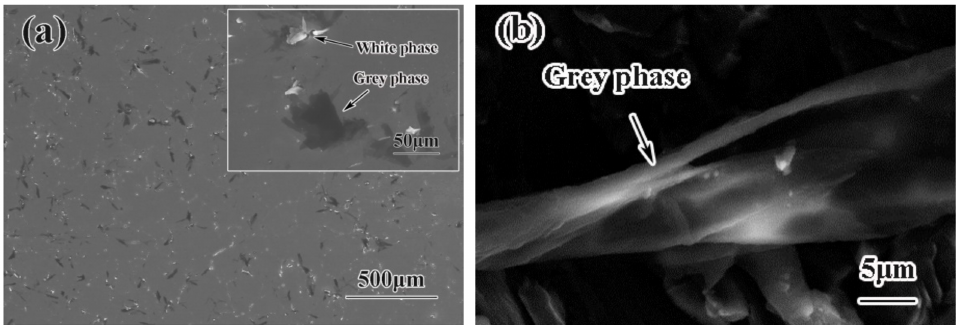
Figure 5. SEM images of GO/TiAl composites. ( a ) at low magnification. ( b ) at high magnification. In order to further verify the dark grey phase in the form of thin film, the film region was processed into a TEM sample. During the process of sample preparation, thinning and double electrolytic can keep the integrity of the phase. TEM diffraction and high resolution were used. As shown in Figure 6, the dark grey phase spread out in the spatial distribution and its local areas are displayed as folded and curled. The thinnest place width of graphene oxide in the composite is about 5